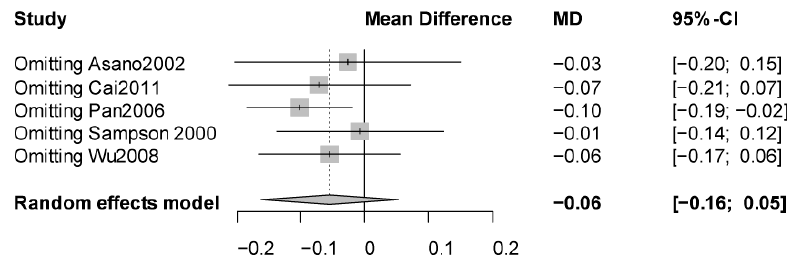
Figure 2. A meta-analysis was performed using random effects model for the association between improvement of lung function parameters and the LTC4S-444A/C polymorphism (AA vs. AC (or AC + CC)). ( a ) Ungrouped meta-analysis; ( b ) subgroup analysis for the types of drugs; ( c ) subgroup analysis for concomitant medication. The center of the green square represents the point estimate of